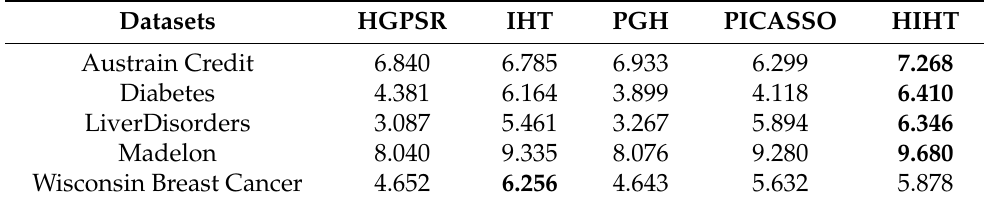
Table 3. Cross entropy of sparse features between different classes.